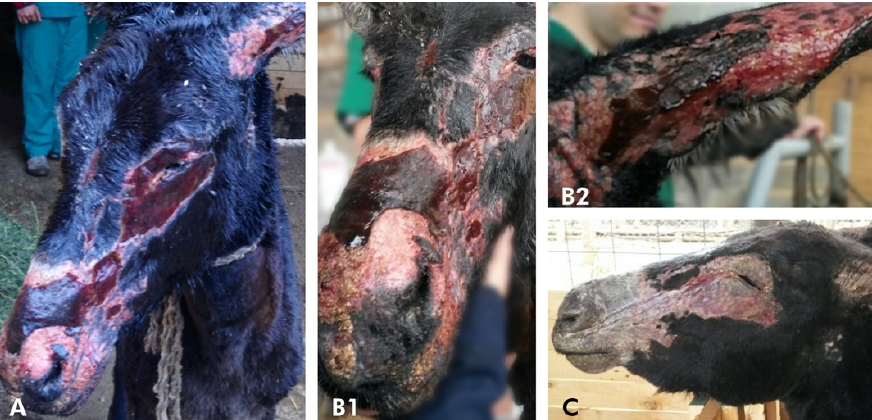
Figure 3. Donkey case 1, showing changes of the burned skin overtime. Appearance of the face after ( A )after5days; ( B1 )12days; ( B2 )12days, externalpinnaareaoftheleftear; and( C ( A ) after 5 days; ( B1 ) 12 days; ( B2 ) 12 days, external pinna area of the left ear; and ( C ) 20 days, respectively.